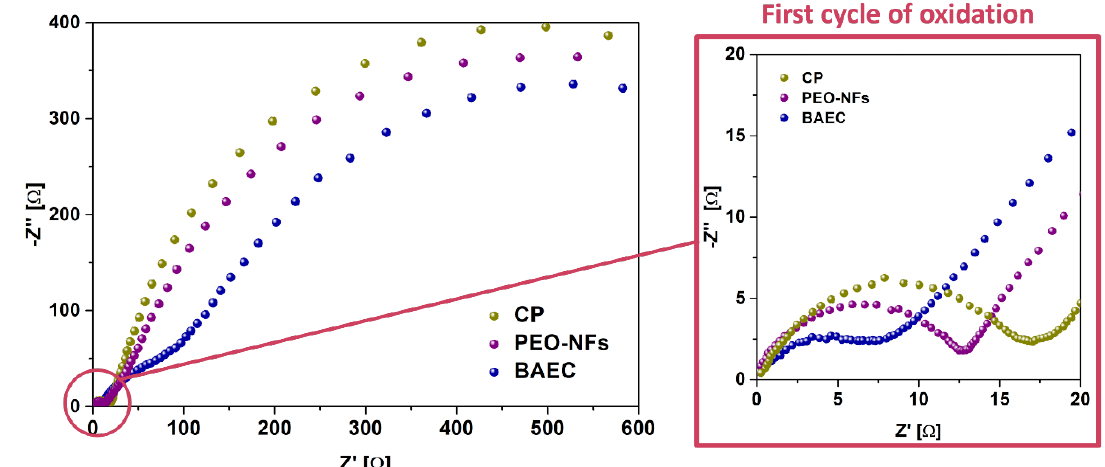
Figure 5. Impedance spectra of CP/PEO NFs (black dot and line representing the experimental data and their fitting) and CP anode (green dot and line) .